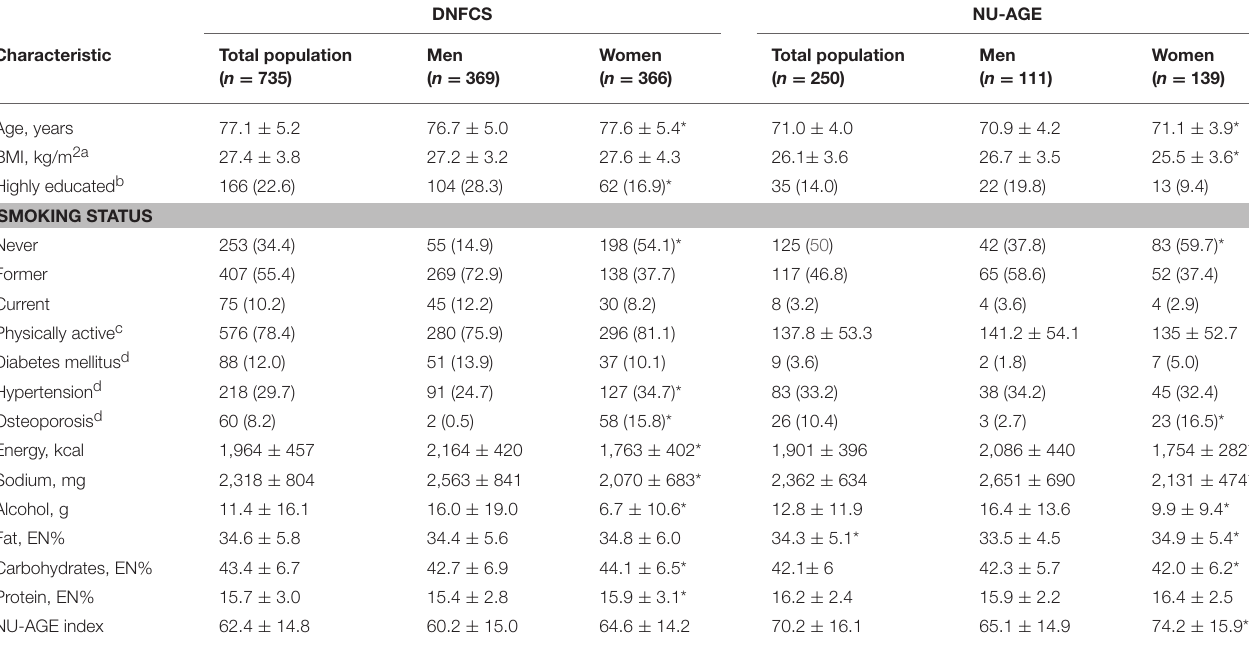
TABLE 5 | Baseline characteristics of the participants of the DNFCS ( n = 735) and NU-AGE study ( n = 250).